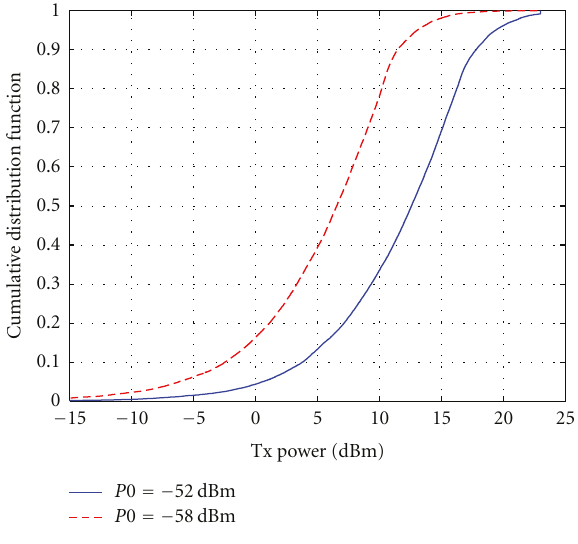
Figure 3: Distribution of Tx Power per PRB.